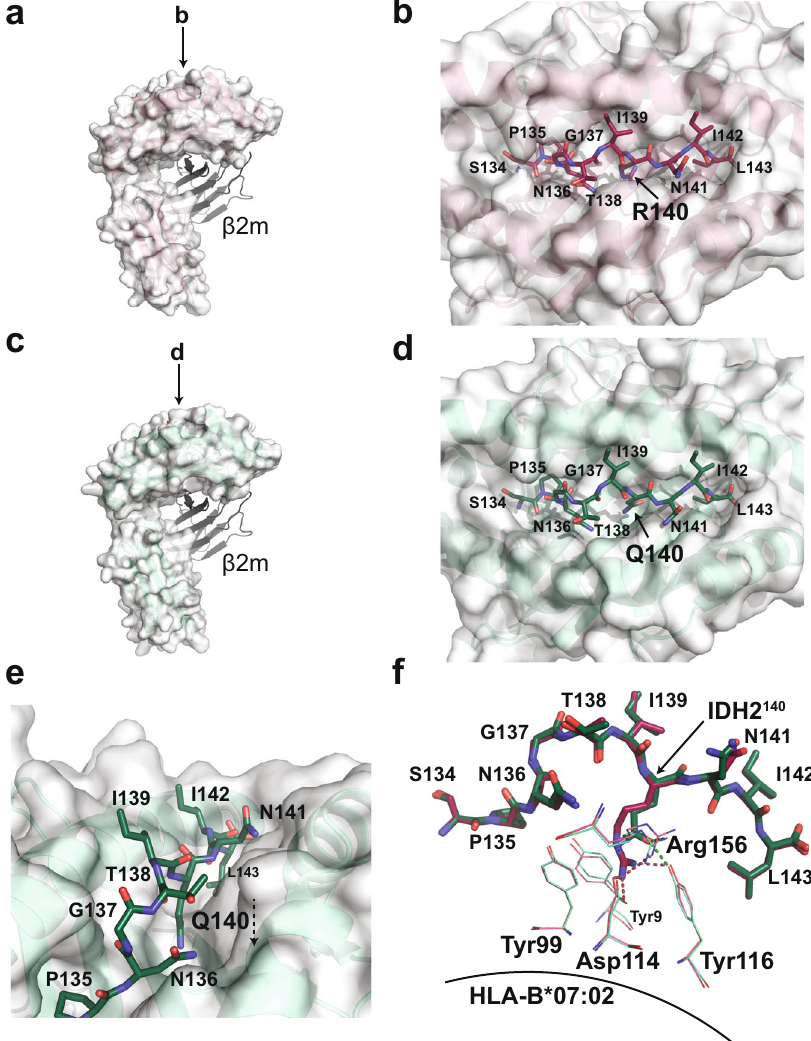
Fig. 2 The IDH2 R140Q epitope is buried in the peptide-HLA-B*07:02 complex. a Overall structure of the IDH2 WT peptide bound to HLA-B*07:02 (PDB ID 6UJ8). The IDH2 WT -HLA-B*07:02 complex is formed as a heterodimer between the heavy chain, represented as a white surface, and β 2-microglobulin, represented as cartoon. The resolution of the IDH2 WT -HLA-B*07:02 structure is 2.25 Å with an average B-factor of 40 Å 2 . b A bird ’ s-eye view of the IDH2 WT peptide sitting in the HLA-B*07:02 peptide-binding groove. Amino acid residues of the IDH2 WT peptide are labeled. c Overall structure of the IDH2 R140Q peptide bound to HLA-B*07:02 (PDB ID 6UJ7). The heavy chain is represented as a white surface, and β 2-microglobulin, represented as cartoon. The resolution of the IDH2 R140Q -HLA-B*07:02 structure is 1.9 Å with an average B-factor of 34 Å 2 . d A bird ’ s-eye view of the IDH2 R140Q peptide bound in the HLA-B*07:02 binding pocket. The residue of interest, IDH2 R140Q , is buried in the peptide-binding groove. e Different orientation of ( d ) highlighting the downward position of the epitope of interest. f Structural alignment of the WT and mutant IDH2 peptides, showing the interactions between the epitope residue of interest and residues on the β -sheet fl oor of HLA-B*07:02. IDH2 peptide residues are labeled with single-letter amino acid codes. The HLA-B*07:02 residues are shown in green (mutant) and raspberry (WT) lines and labeled with three-letter amino acid codes; hydrogen bonds are represented as dotted